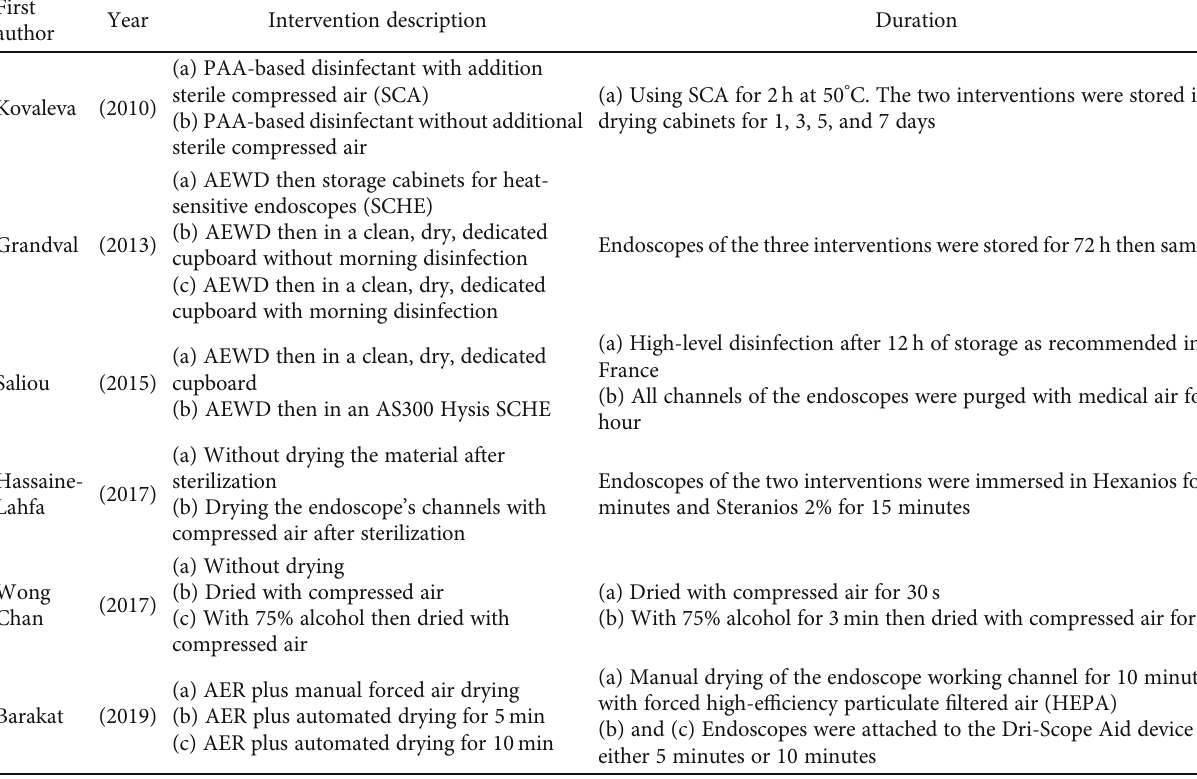
Table 3: Characteristics of the interventions.